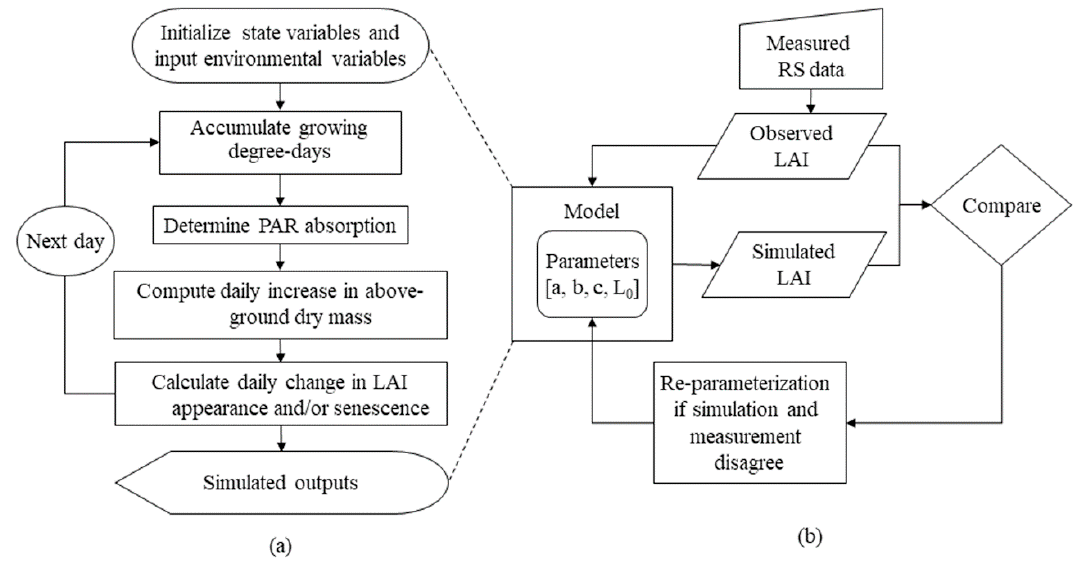
Figure 1. Diagrammatic representation of the remote sensing-integrated crop model (RSCM) model: ( a ) crop simulation procedure and ( b ) ‘within-season calibration’ for model parameterization using proximal or remote sensing information. LAI, PAR, and RS represent leaf area index, photosynthetically active radiation, and remote sensing, respectively.